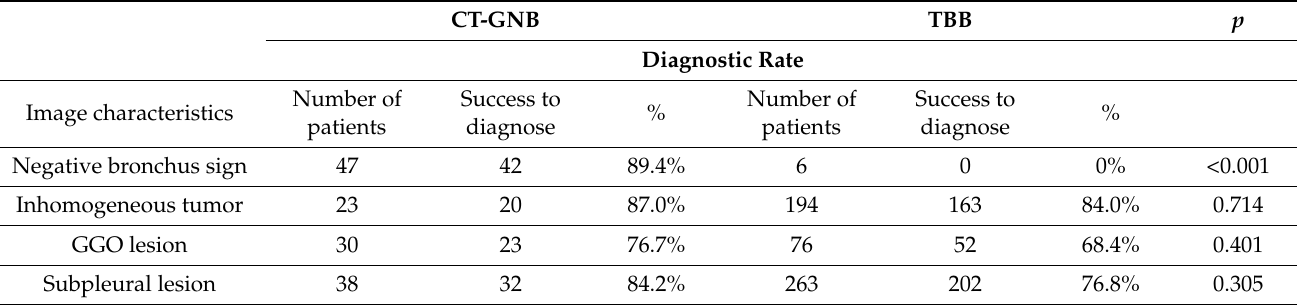
Table 4. Diagnostic rate of CT-GNB and TBB in relation to various image characteristics.